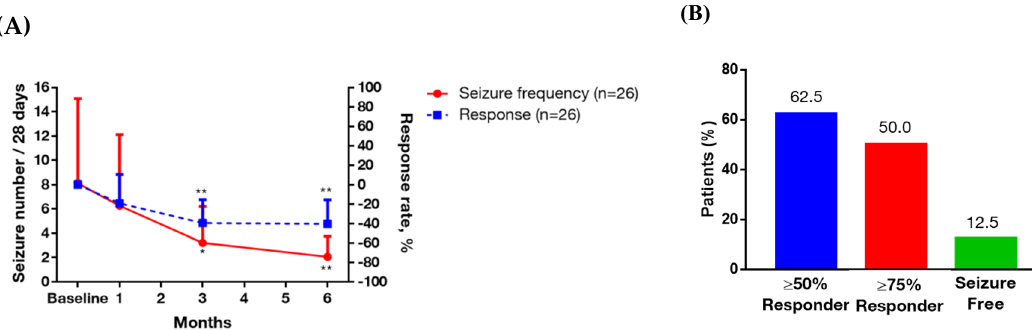
Figure 1. Trend of seizure frequency, treatment response rate and responder rate after six months of multivitamin supplementation in the patients with intractable focal epilepsy. Data are presented as mean ± 95% confidence interval (above). ( A ) Left y-axis represents seizure frequency, right y-axis represents treatment response rate, and x-axis displays time (by month). Significance was calculated using generalized estimating equation analysis, comparing baseline and after multivitamin supplementations. * p < 0.05, ** p < 0.01. ( B ) Responder rate. Percentage calculations are based on the number of subjects at the final visit.